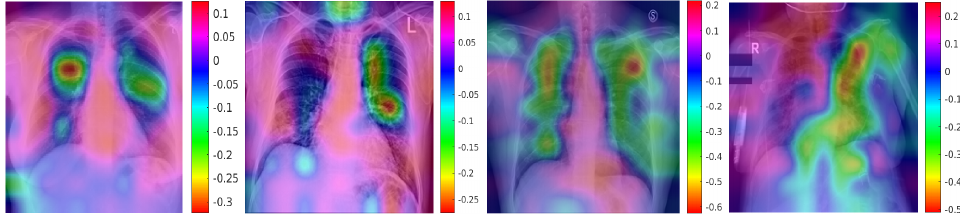
Figure 12. ROI for positive Covid-19 cases using